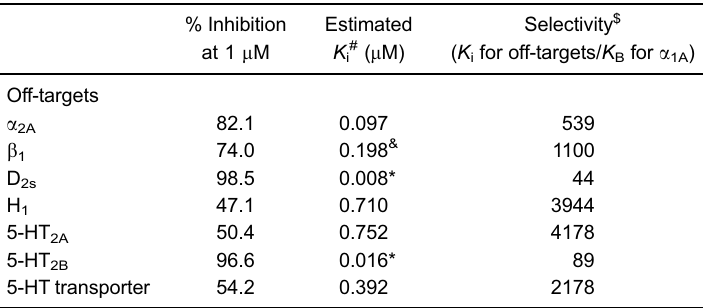
Table 4. LDT5 af fi nity for benign prostatic hyperplasia (BPH) off-target receptors. % Inhibition at 1 m